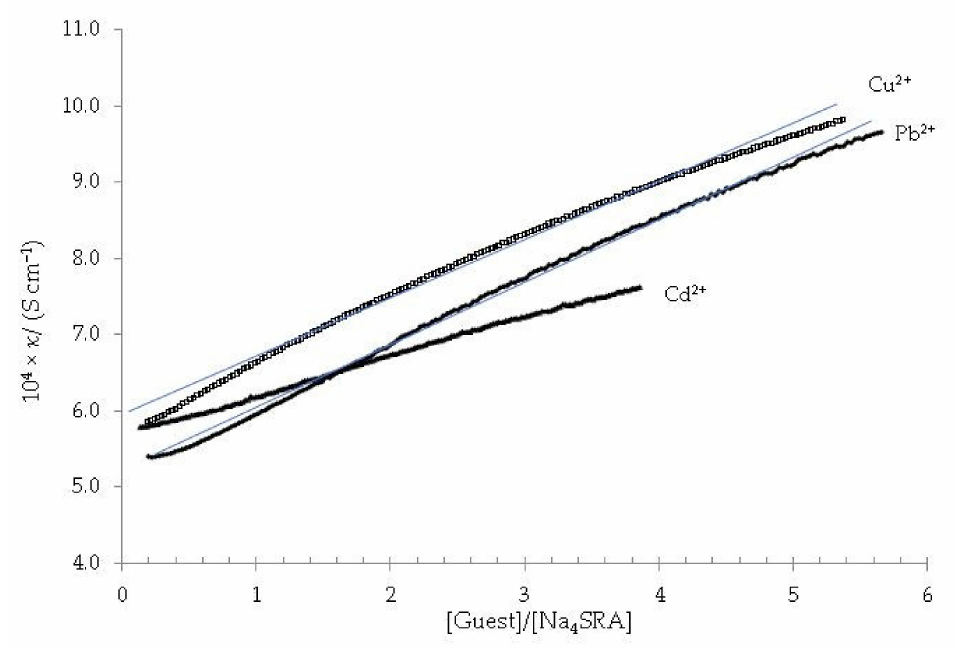
Figure 8. Specific conductivity versus the [guest]/[Na 4 SRA] ratio; being the guest ( ∆ ) Pb 2+ , ( ♦ ) Cd 2+ , ( • ) Cu 2+ . The solid blue lines are displayed as a visual aid to see that there is no appreciable change in the slope of the